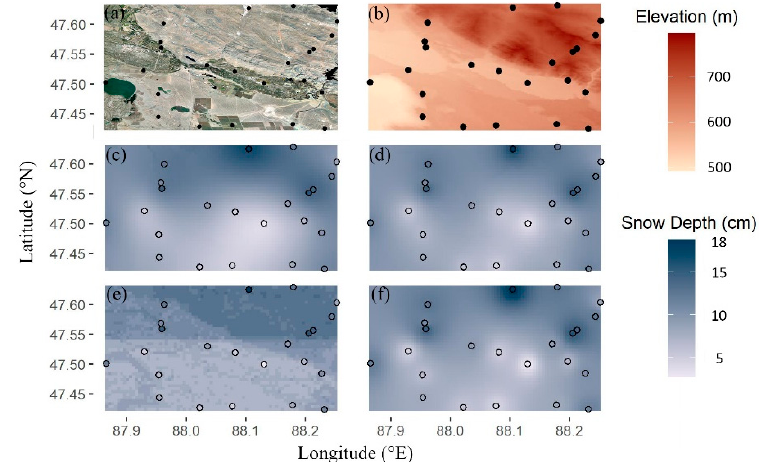
Figure 1. Upscaling results comparison of ( c ) ordinary Kriging, ( d ) simple Kriging, ( e ) random forest, and ( f ) Bayesian maximum entropy, for a 25 km 2 plot; the satellite image and DEM for the snow plot are shown in ( a ) and ( b ), respectively.